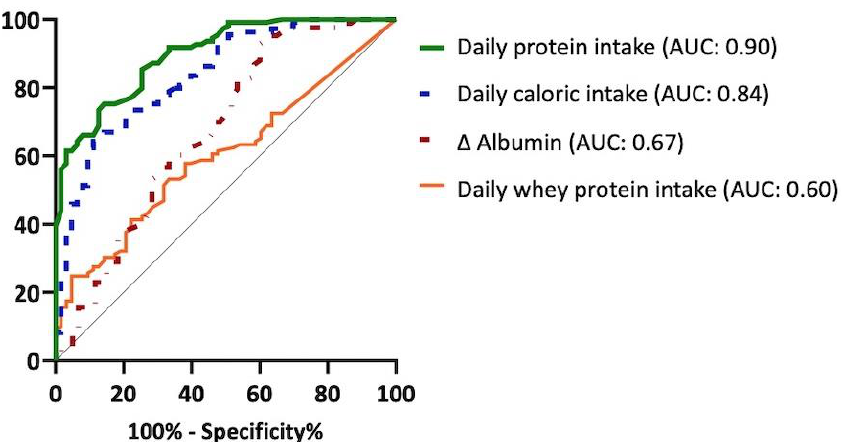
Figure 2. ROC curve of weaning outcomes with nutritional parameters. ROC, receiver operating characteristic; AUC, area under curve; ∆ albumin, difference between the 4th week and baseline serum albumin levels.